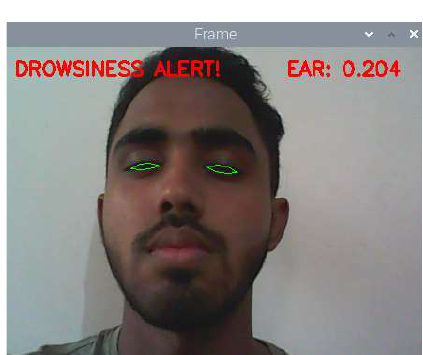
Figure 6: EAR=0.204